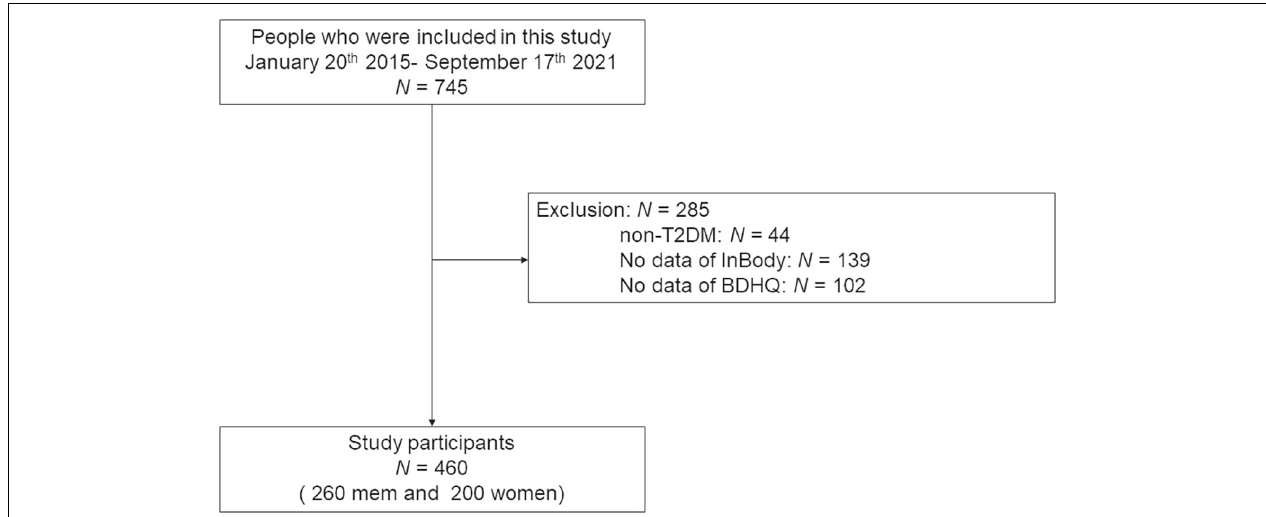
FIGURE 1 | Study flow diagram for the registration of